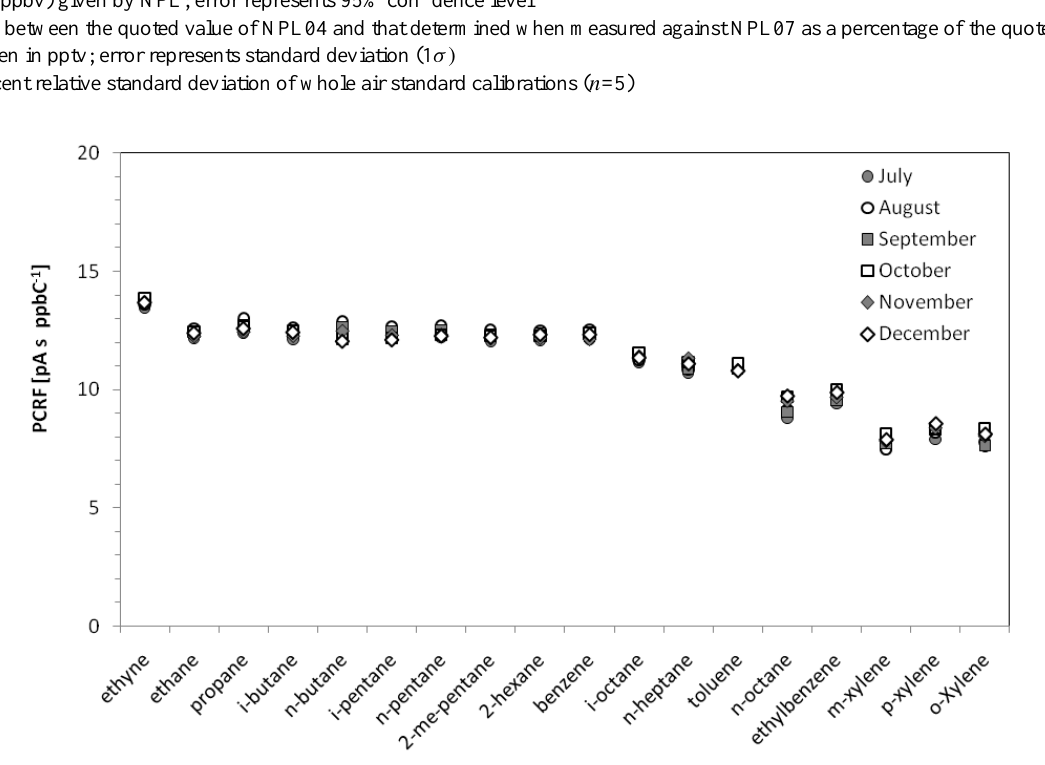
Fig. 3. Six month (July–December 2008) time series of per carbon response factors (PCRFs) determined from the average of the monthly analyses of the NPL standard. Standard deviations are omitted for clarity, but in each month were lower than 1% for C ≤ 6, and between 1 and 5% for higher carbon numbers. Compounds are listed in order of increasing retention